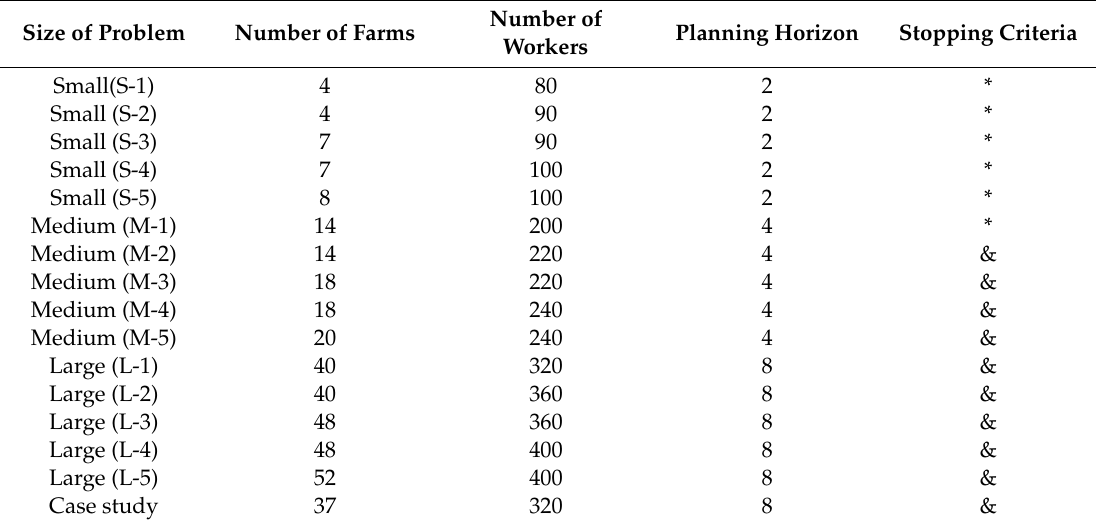
Table 7. Details of the test instances.